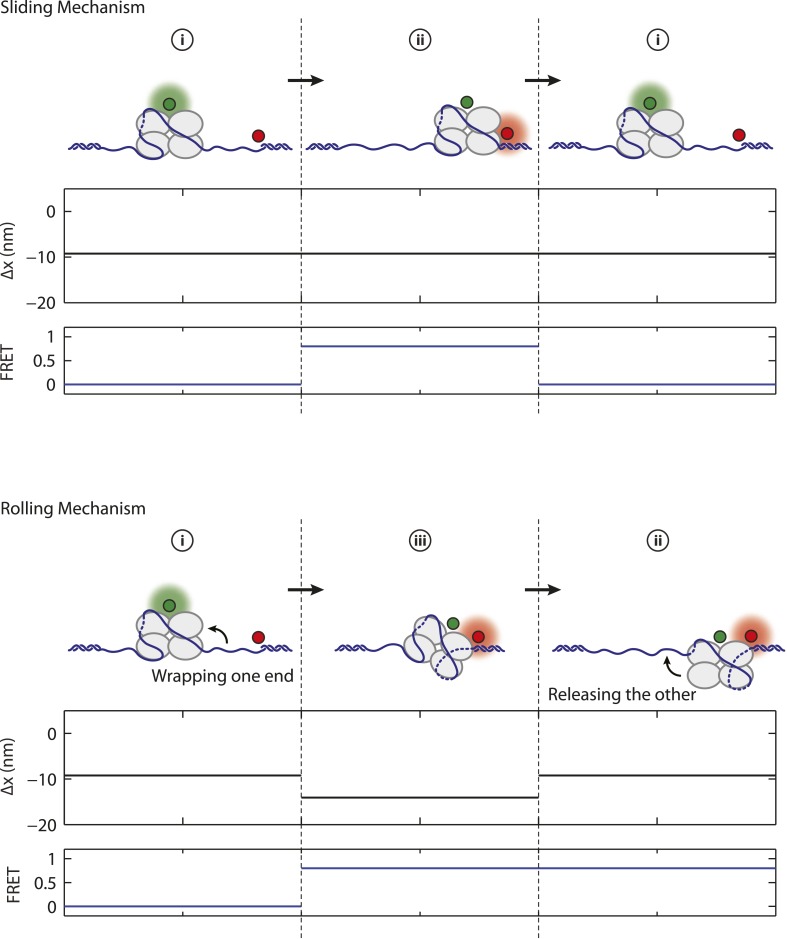
Mechanism of SSB diffusion.Cartoon illustrations of nucleoprotein complexes diffusing along ssDNA with different proposed mechanisms. Schematic FRET efficiency and Δx displaying multiple transitions between states (i, ii, iii, iv). In a sliding or reptation mechanism, FRET transitions occur independently of changes in wrapping state (top panel). A rolling mechanism involves SSB displacement by wrapping one end of DNA followed by releasing the other (bottom panel; i → iii → ii or ii → iii → i). No examples (0 of N = 82) of rolling are observed in our experiment.